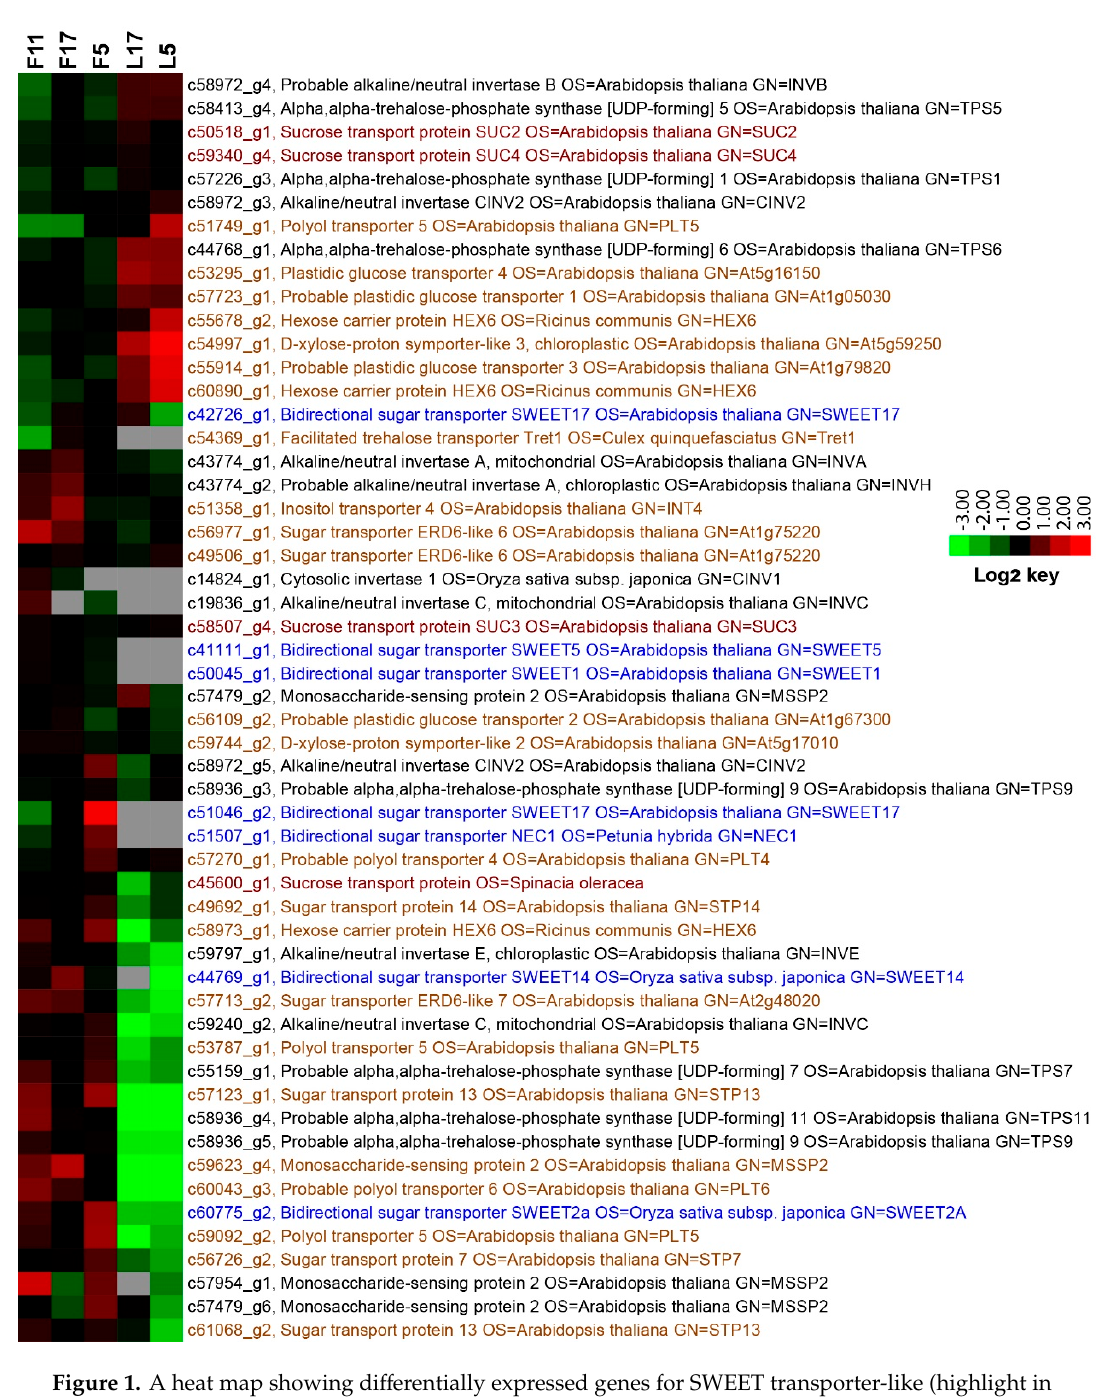
Figure 1. A heat map showing di ff erentially expressed genes for SWEET transporter-like (highlight in blue), sucrose transporter-like (in red) and monosaccharide transporter-like (in orange), invertases-like and trehalose-6-phosphate synthase-like in J. sambac flowers and leaves at indicated time of the day. Genes were clustered by uncentered Pearson correlation with average linkage ordering, using Cluster 3.0 (version 1.57). The log 2 -transformed fold change is indicated by the color bar. Samples F11, F17, F5, and L17, L5: flowers at 11:00, 17:00, 05:00, and leaves at 17:00,